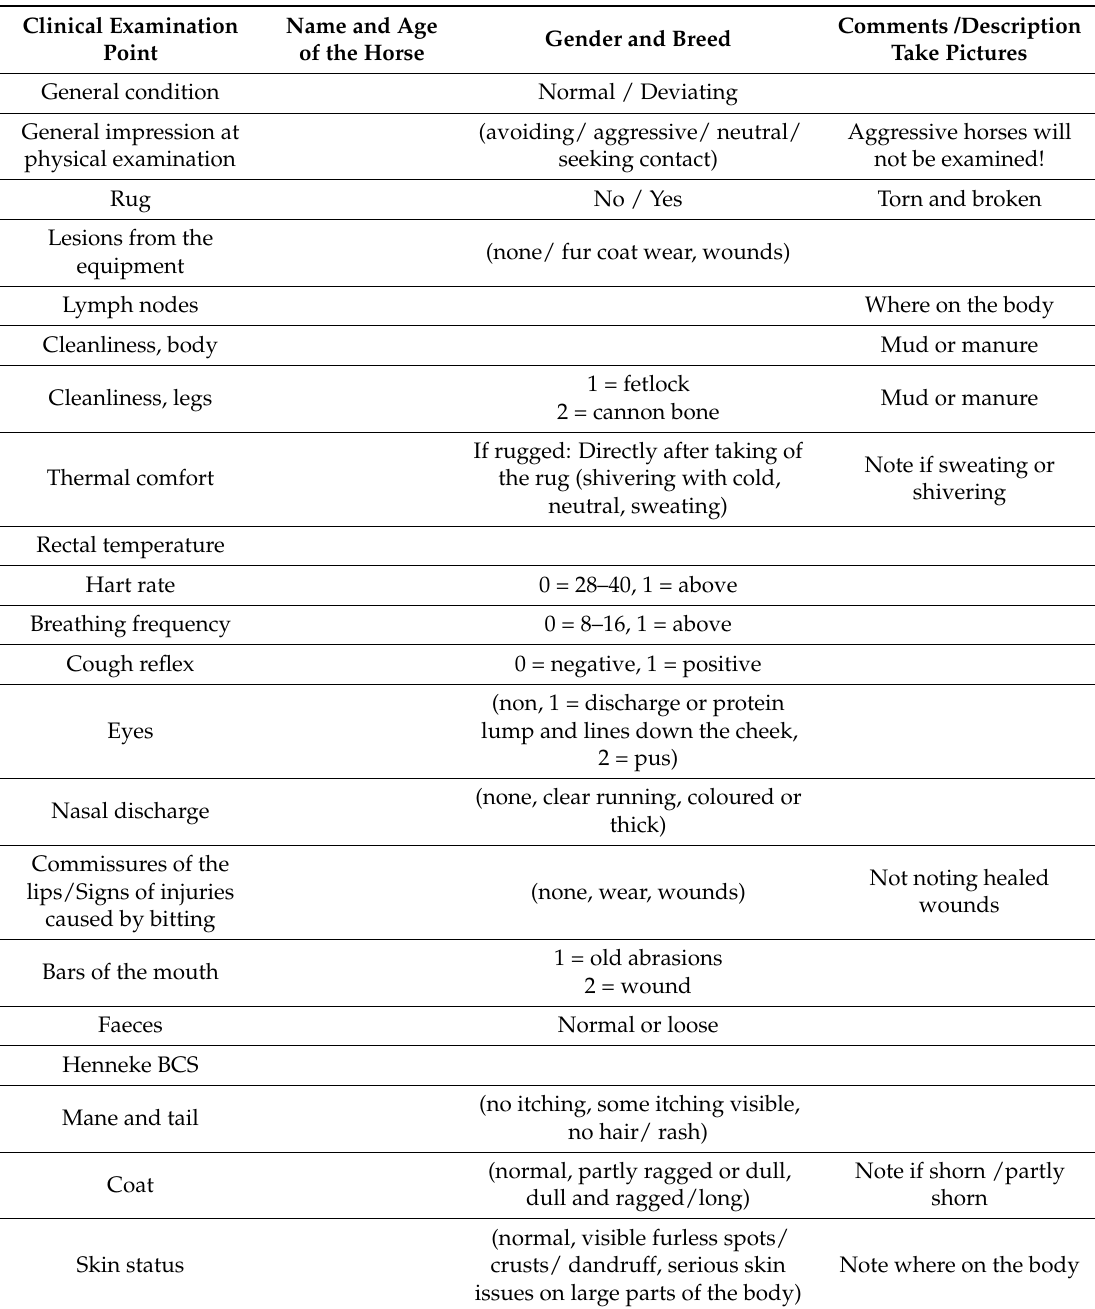
Table A1. TJK: Protocol used in clinical